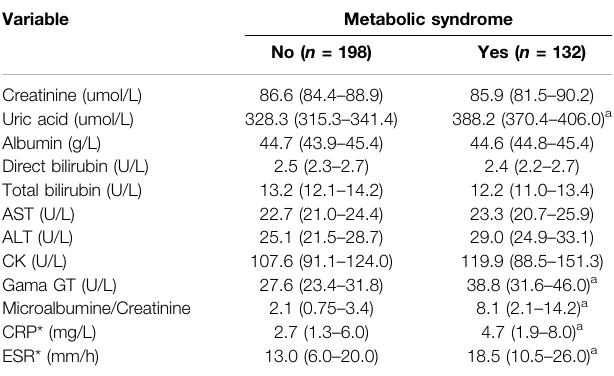
TABLE 4 | Clinical, lipids and in fl ammation parameters of the study population according to metabolic syndrome.